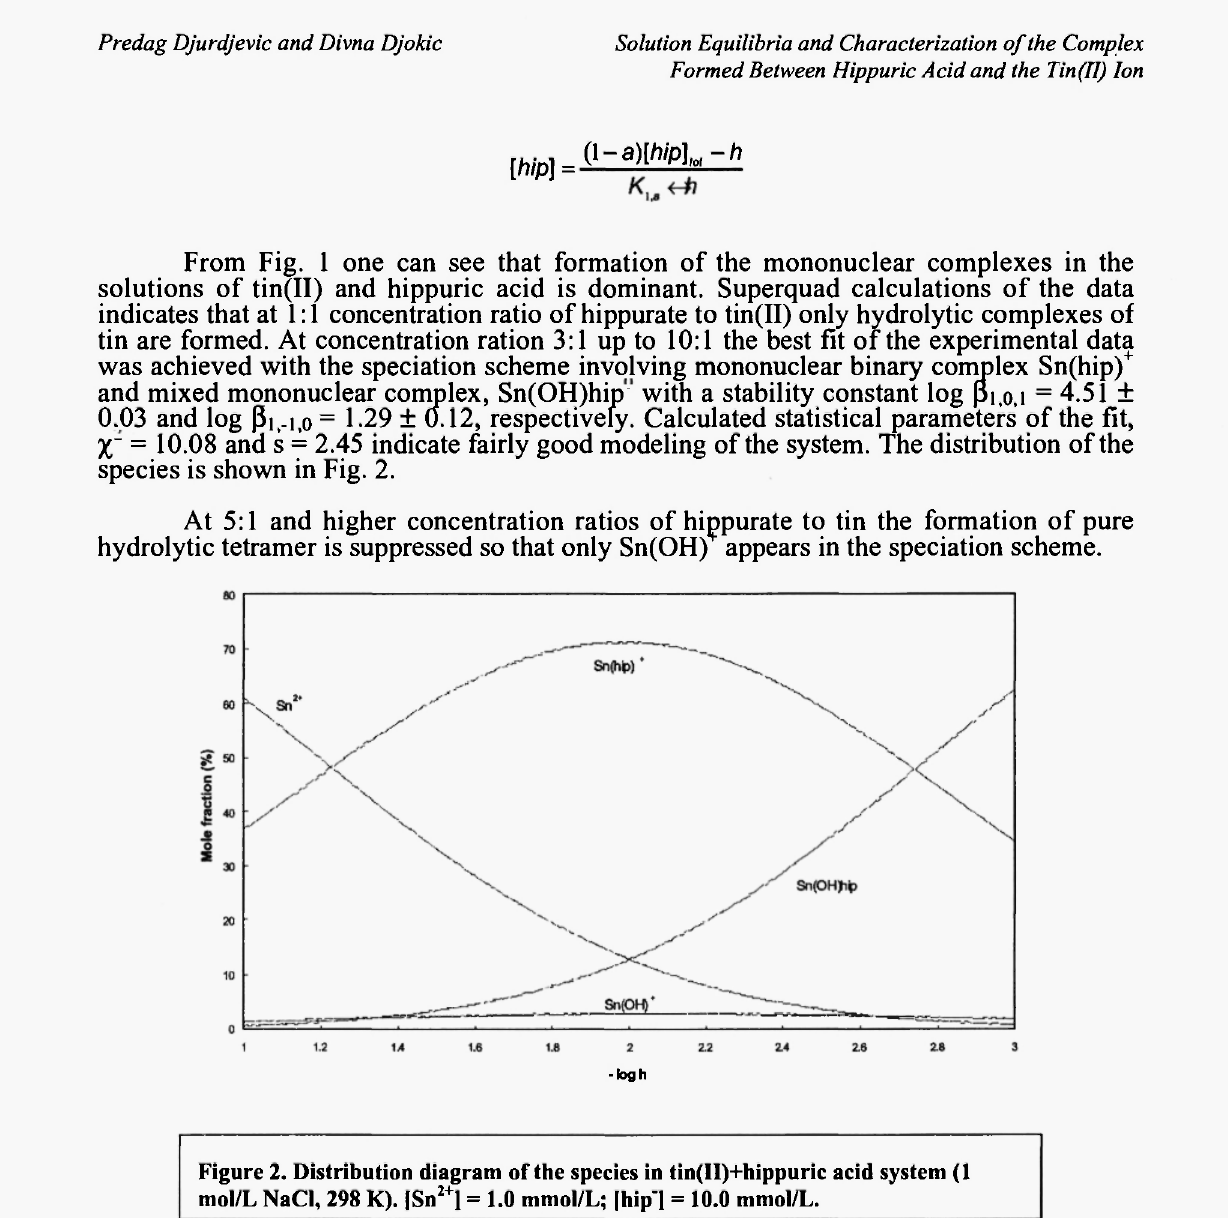
Figure 2. Distribution diagram of the species in tin(II)+hippuric acid system